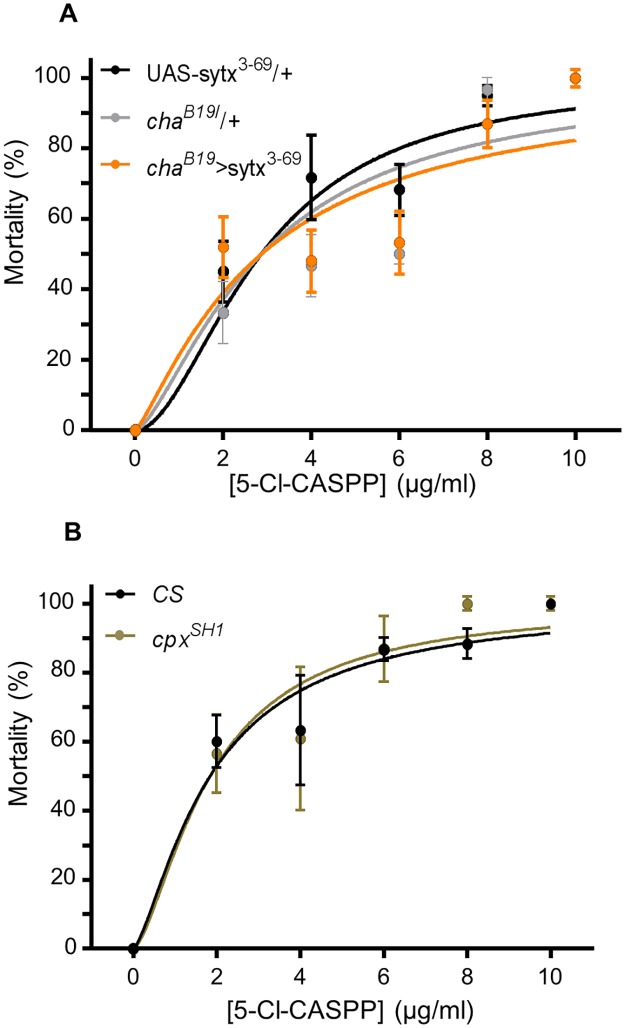
Alternative routes that maintain mini release fail to provide resistance to 5-Cl-CASPP.(A) Expression of sytx3-69 in cholinergic neurons is sufficient to increase mini frequency (see text) but does not afford resistance to 5-Cl-CASPP. The observed LD50 values were: 3.8 ± 0.5, 2.6 ± 0.3 vs. 2.4 ± 0.4 μg/ml, +/chaB19 (n = 60 larvae tested per concentration), +/sytx3-69 (n = 60 per concentration) vs. chaB19> sytx3-69 (n = 80 per concentration) respectively, P = 0.07). (B) The cpxSH1 mutant similarly has no resistance to 5-Cl-CASPP. Observed LD50 values in this case were: 1.7 ± 0.2 vs. 2.0 ± 0.3, CS vs. cpxSH1 respectively, n = 60 per concentration, P = 0.73). All data points shown are mean ± sem.